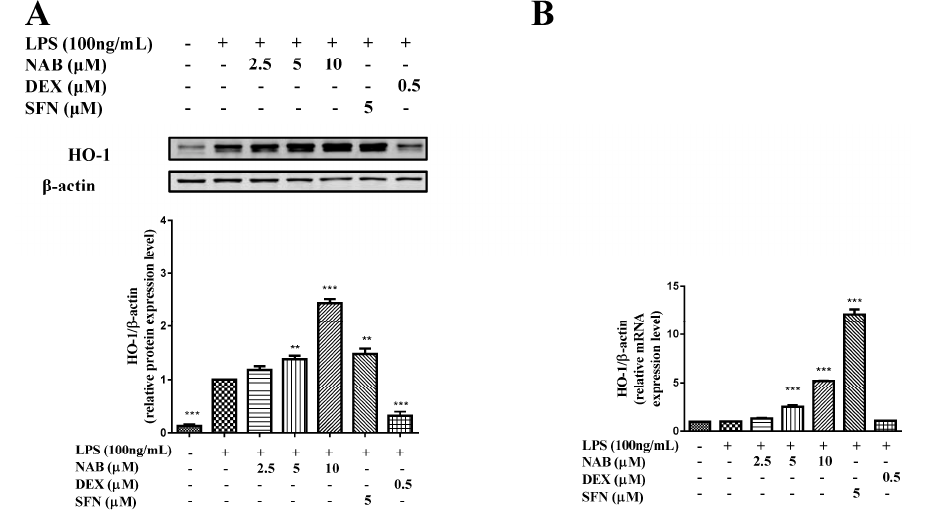
Figure 4. The e ff ect of NAB on expression level of HO-1 in LPS-stimulated RAW264.7 cells. ( A ) E ff ect of NAB on HO-1 expression level in LPS-stimulated RAW264.7 cells. Cells were pretreated with NAB or positive control drug (dexamethasone, DEX) for 1 h and then stimulated with LPS (100 ng / mL) for 6 h. The total protein of the cells was prepared, and the expression level of HO-1 protein was measured by Western blotting. ( B ) E ff ect of NAB on the mRNA expression level in LPS-stimulated RAW264.7 cells. Cells were pretreated with NAB or positive control drug (dexamethasone, DEX, or sulforaphane, SFN) for 1 h and then stimulated with LPS (100 ng / mL) for 6 h. The total mRNA was prepared, and the expression level was evaluated by qRT-PCR. The density ratio of the LPS group (model control) was set to 1. Results are expressed as the mean ± SEM of three independent experiments. ** P < 0.01 and *** P < 0.001 vs. LPS-stimulated cells.